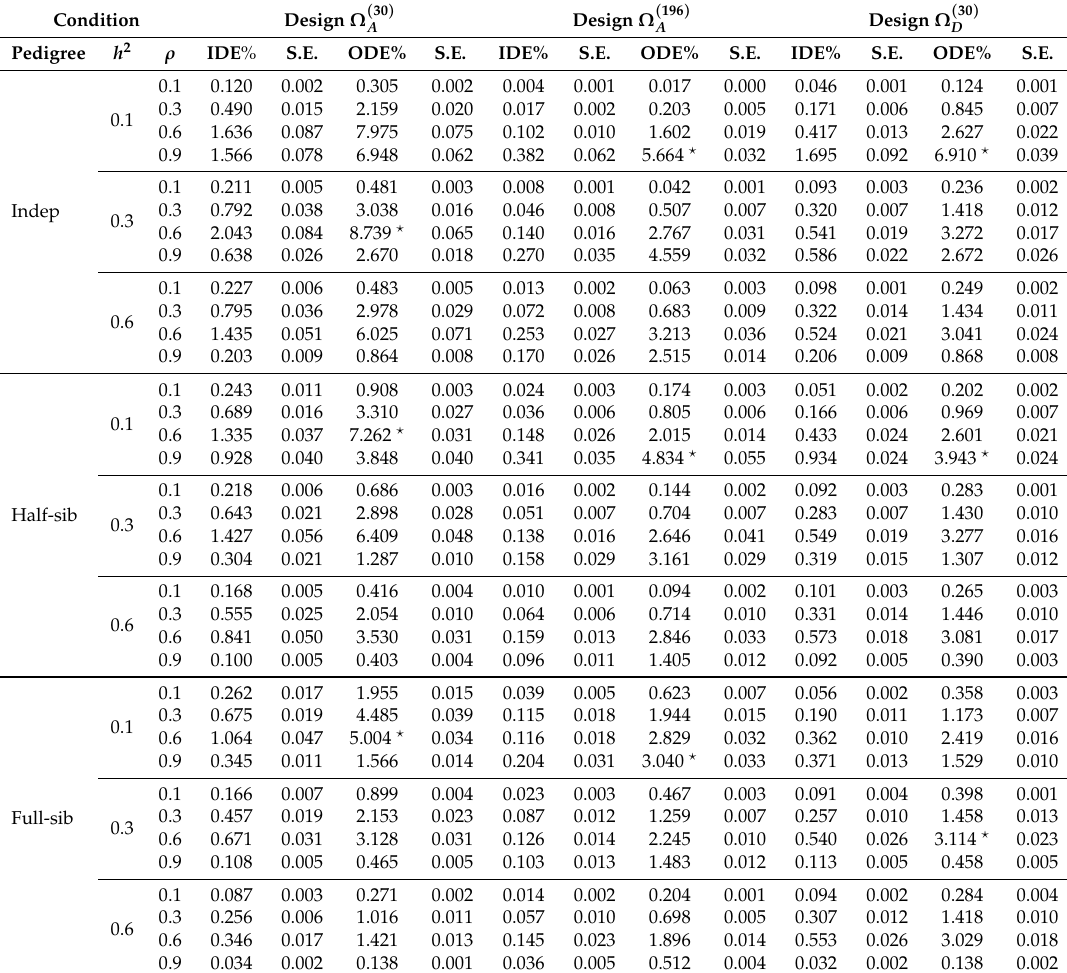
Table 1. Summary statistics for Initial Design Efficiency (IDE%) and Overall Design Efficiency (ODE%) for randomized complete block (RCB) designs with 30 genotypes generated using A -optimality criterion ( 30 ) Ω ( 30 ) and D -optimality criterion Ω and for 196 genotypes generated using A -optimality criterion D A Ω ( 196 ) . All designs were evaluated with λ = 10 replicates per condition and iterated p = 5000 times A to improve the experimental layouts. ODE mean values that are starred ( (cid:63) ) are the overall largest improvements per combination of pedigree and heritability